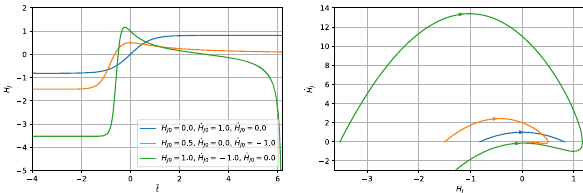
Fig. 2 TheHubbleparameter H J ( ˜ t ) (left)andthecorrespondingphase portraits (right)